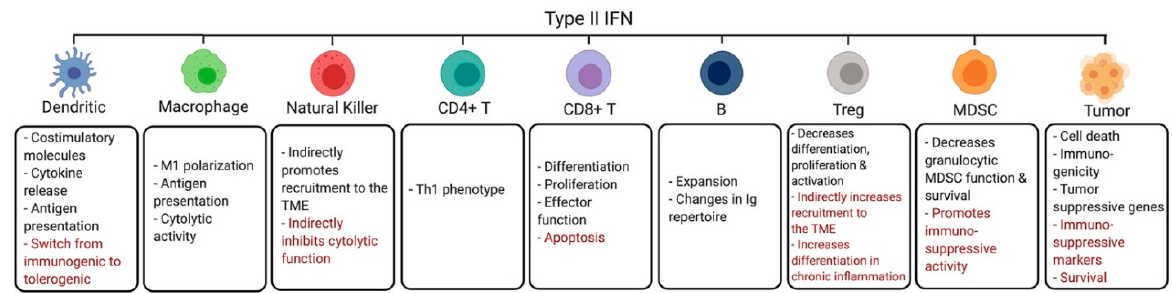
Figure 2. Effects of the type II interferon (IFNII) on malignant cells and different types of immune cells. Exposure to type II IFN alters the function of the tumor and immune cells within the TME in ways that promote anti-tumor effects (black) or counter such effects (red).